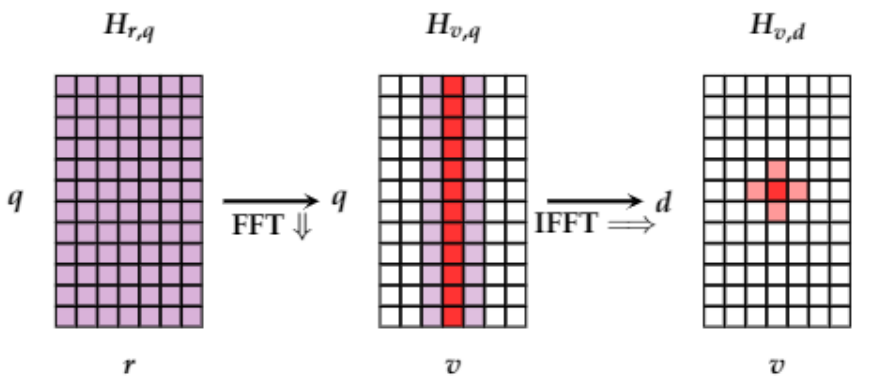
Figure 3. Two-dimensional (2D) periodogram processing